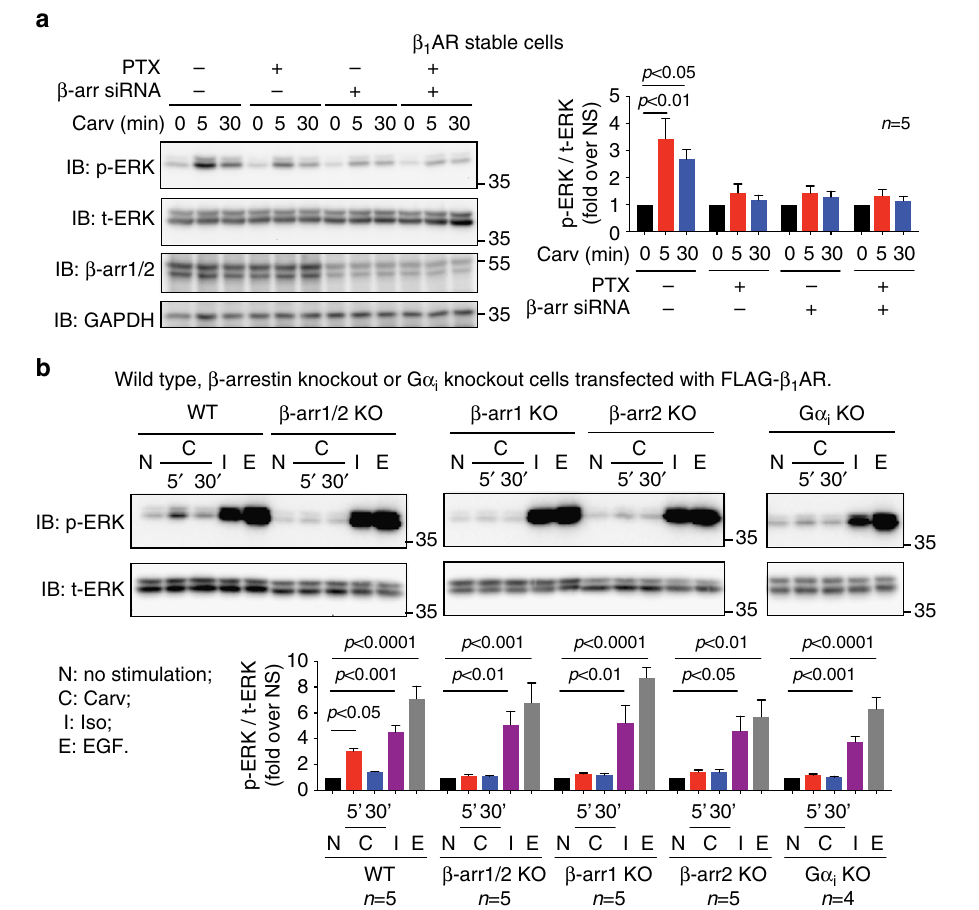
Fig. 6 Carvedilol-induced β 1 AR-mediated ERK phosphorylation is dependent on both G α i and β -arrestins. a The effect of PTX and β -arrestin knockdown on carvedilol-stimulated ERK phosphorylation. β 1 AR stable cells with transfection of control siRNA or β -arrestin1/2 siRNA were pretreated with vehicle or PTX, then simulated with 10 μ M carvedilol for 5 min or 30 min. Carvedilol-stimulated ERK phosphorylation was diminished by either PTX pretreatment or β - arrestins siRNA, suggesting the requirement of G α i and β -arrestins for this signaling. b The β 1 AR-mediated ERK phosphorylation in β -arrestin or G α i knockout cells. Wild type, β -arrestin knockout or G α i knockout HEK293 cells were transfected with FLAG-tagged β 1 ARs. Cells were stimulated with 10 μ M carvedilol for 5 or 30 min, 10 μ M isoproterenol or 10 ng per ml EGF for 5 min. The depletion of either β -arrestins or G α i impaired carvedilol-induced ERK phosphorylation. Data represent the mean ± SEM for n independent experiments as marked on the fi gure. Statistical signi fi cance vs. unstimulated cells was assessed using one-way ANOVA with Bonferroni